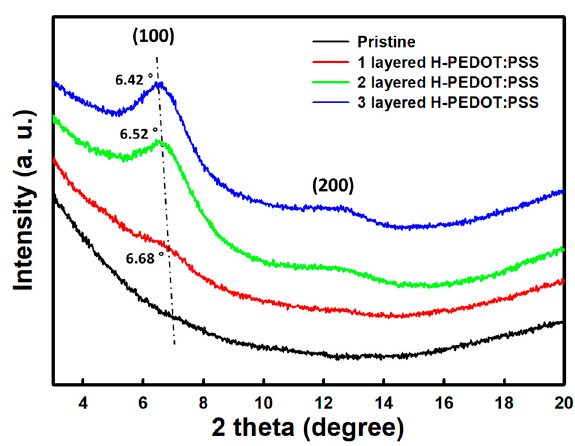
Figure 4. XRD patterns for the pristine PEDOT:PSS film and PEDOT:PSS films with the sulfuric acid etching treatment.